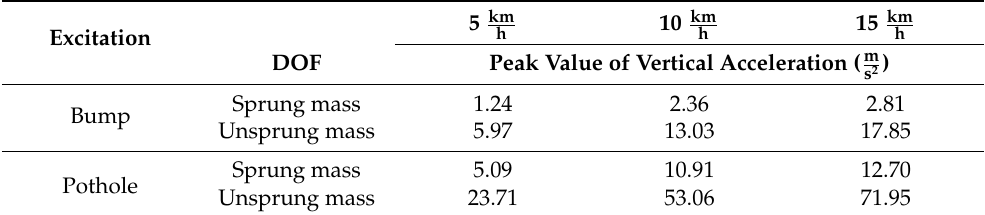
Table 7. The values of the peak accelerations of the sprung and the unsprung mass of the QC model for the single disturbance